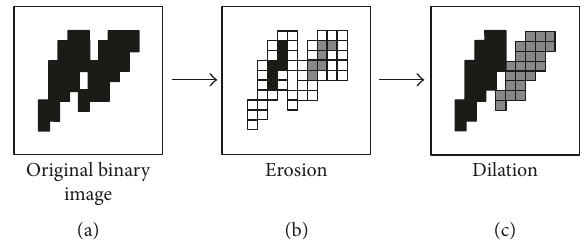
Figure 1: Separating attached fish images using morphological operations